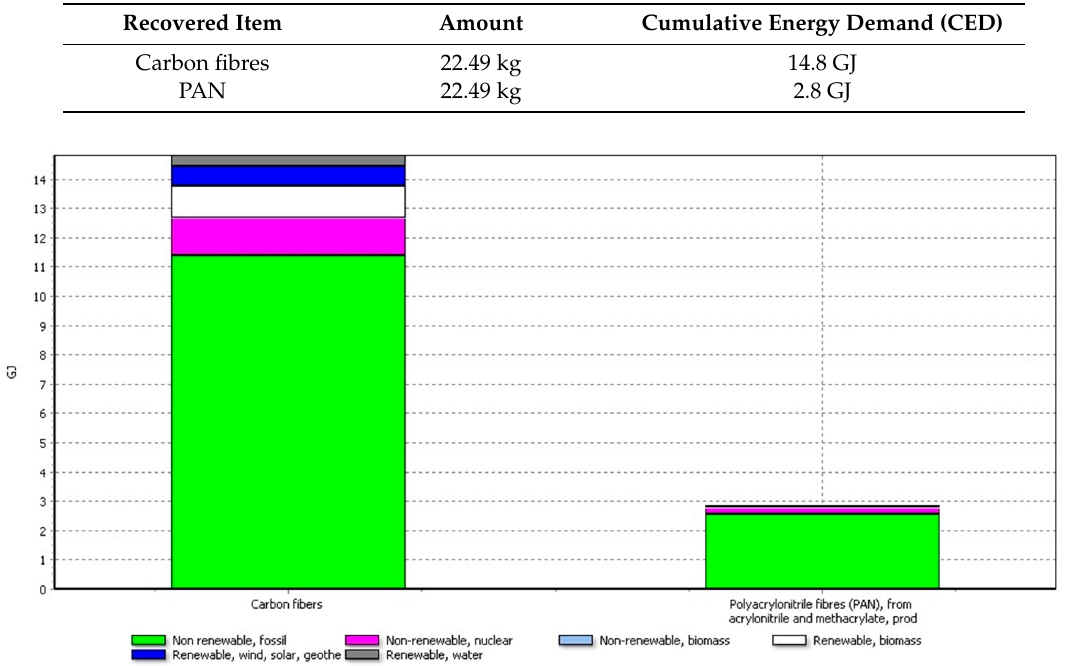
Table 6. Cumulative Energy Demand.